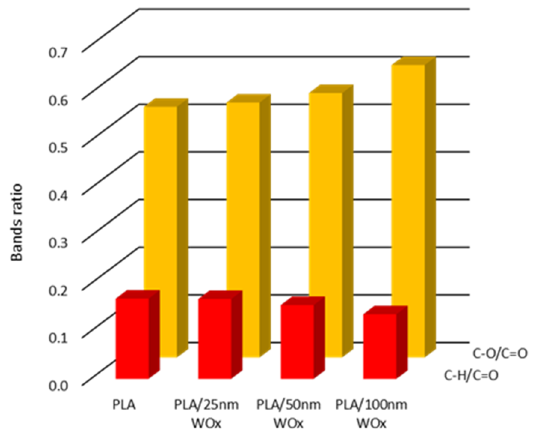
Figure 3. FTIR spectra of ( a ) pristine PLA and ( b ) PLA/WO x samples.